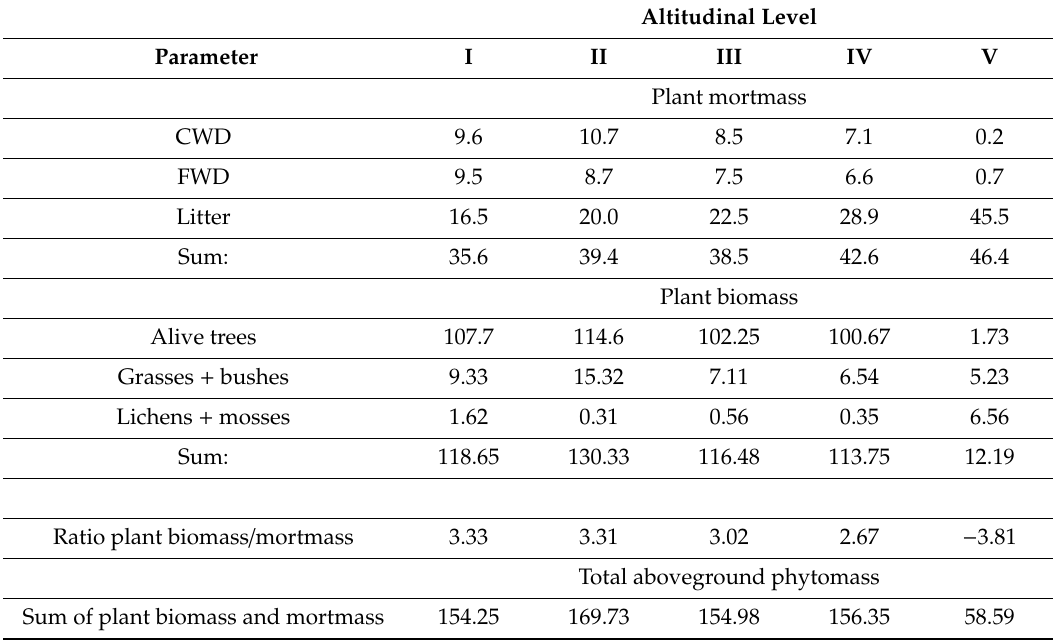
Table 3. Distribution of aboveground plant mortmass, biomass and total phytomass (t / ha) along the altitudinal